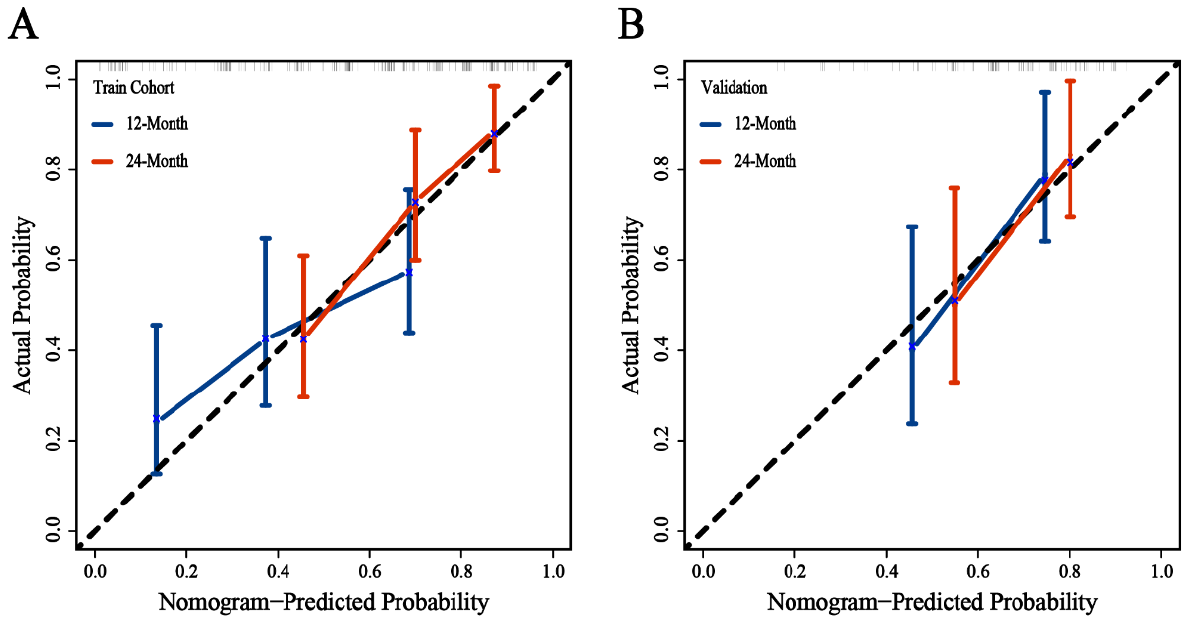
Figure 4. Calibration curves of the nomogram prediction in training ( A ) and validation cohort ( B ).